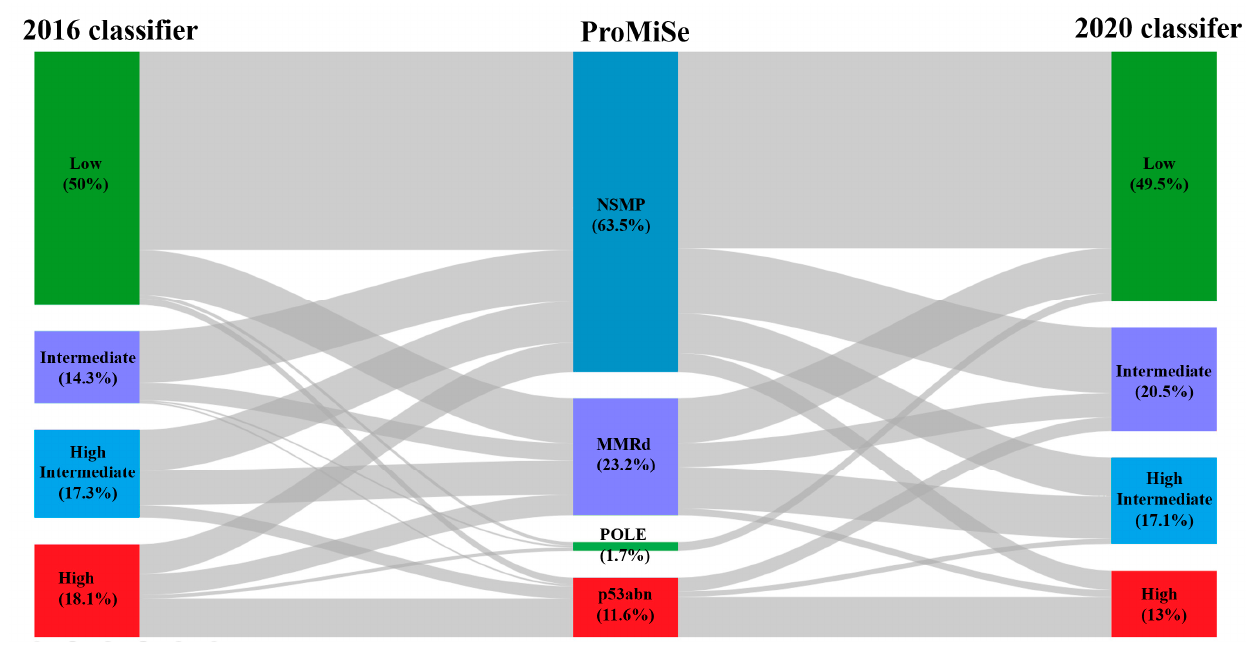
Figure 2. Sankey diagram. Risk groups are illustrated by coloured boxes, and percentage of cases within them are included for each classifier. Grey areas indicate case redistribution flow.